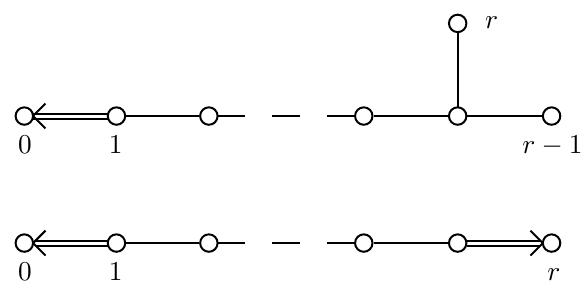
Figure 1 . Dynkin diagrams of B (1) r (upper) and D (2)